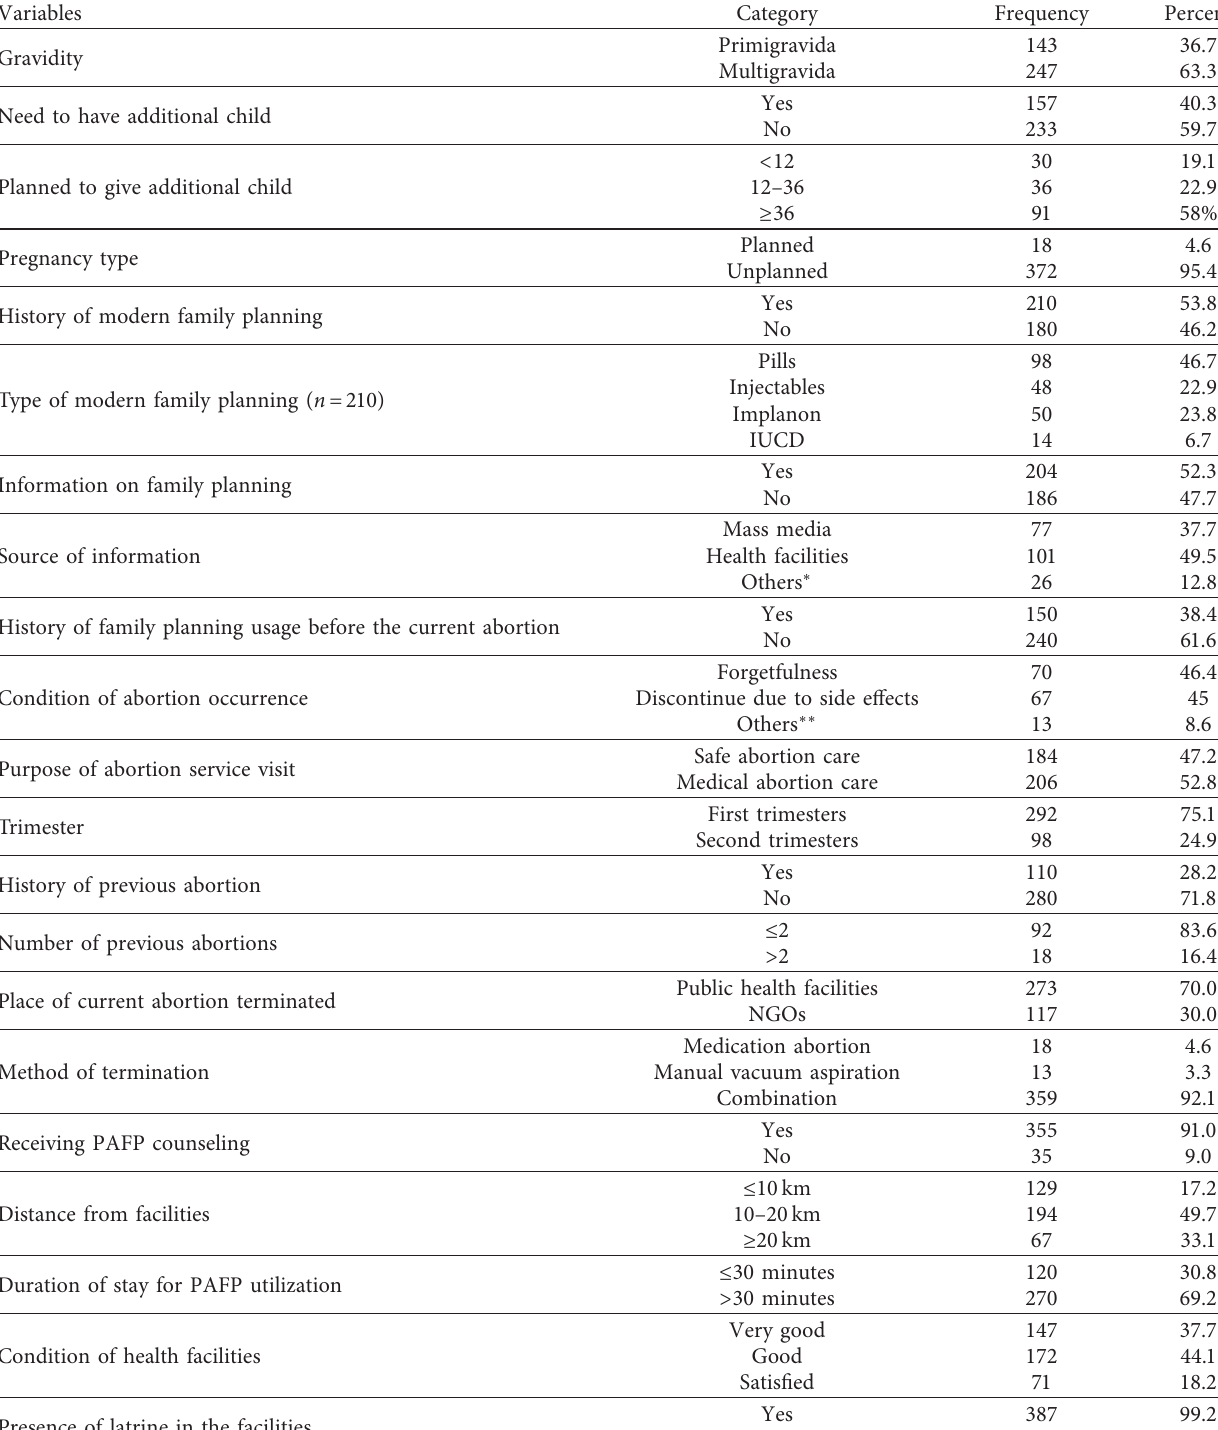
Table 2: Obstetrics, contraceptive, and health care-related characteristics of study participants in the health facilities of Harar Town, Eastern Ethiopia ( N �